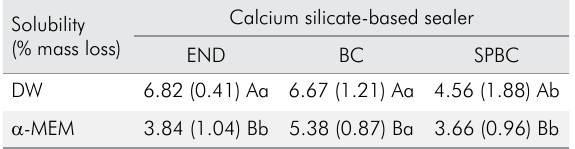
Table 2. Mean solubility values and standard deviation revealed in calcium silicate-based sealer after storage in DW and α